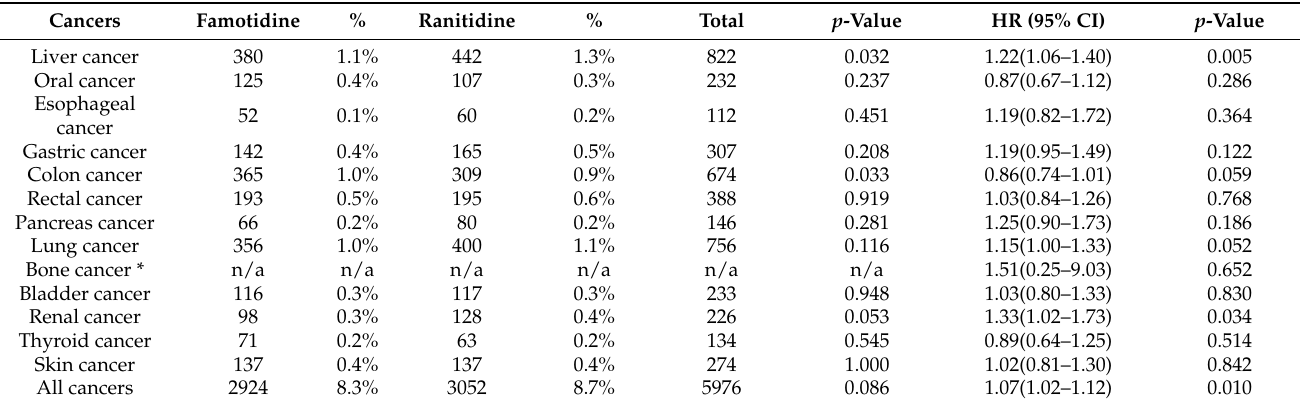
Figure 5. ( A ) Cumulative incidences of liver cancer between ranitidine and famotidine users after adjustment for competing risks. ( B ) Cumulative incidences of liver cancer among ranitidine, non-ranitidine with famotidine, and non-ranitidine without famotidine users after adjustment for competing risks. Table 4. Risk of cancer between famotidine and ranitidine users.